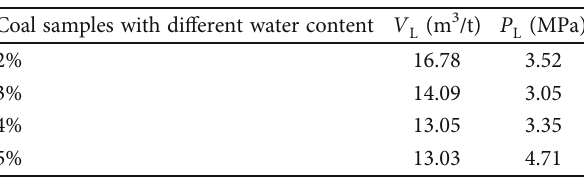
Figure 3: Methane adsorption isotherms of di ff erent salinities with the water content of 3wt % at 338.15K. Points are results of simulation, and lines are results of Langmuir fi tting [20]. Table 4: Langmuir isothermal adsorption parameters of Baode coal samples with di ff erent water